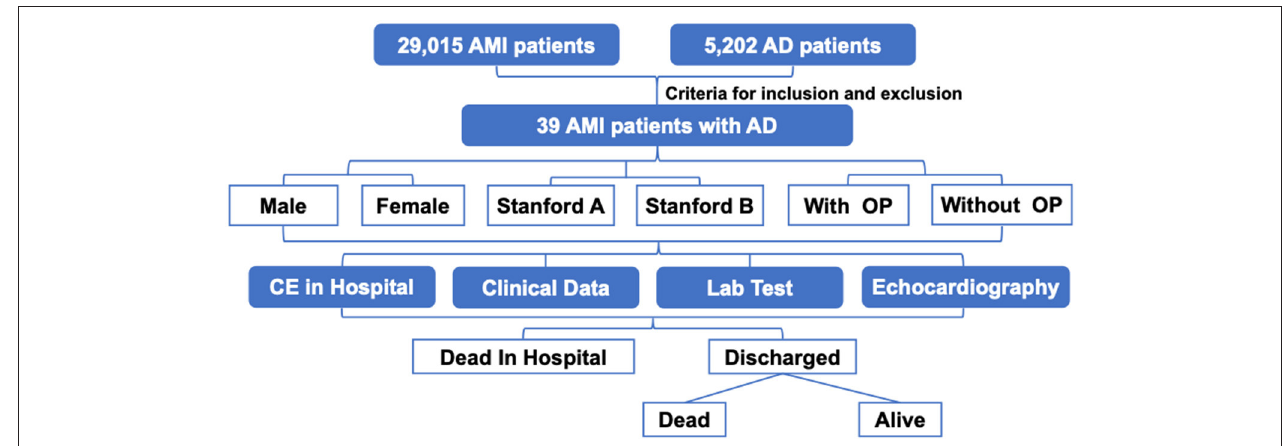
FIGURE 1 | The protocol of this study. There were 39 patients with AD and AMI among 29,015 patients who were hospitalized with AMI and 5,202 patients with AD; All of them completed the follow-up. AD indicates aortic dissection; AMI, acute myocardial infarction; CE, cardiac events.